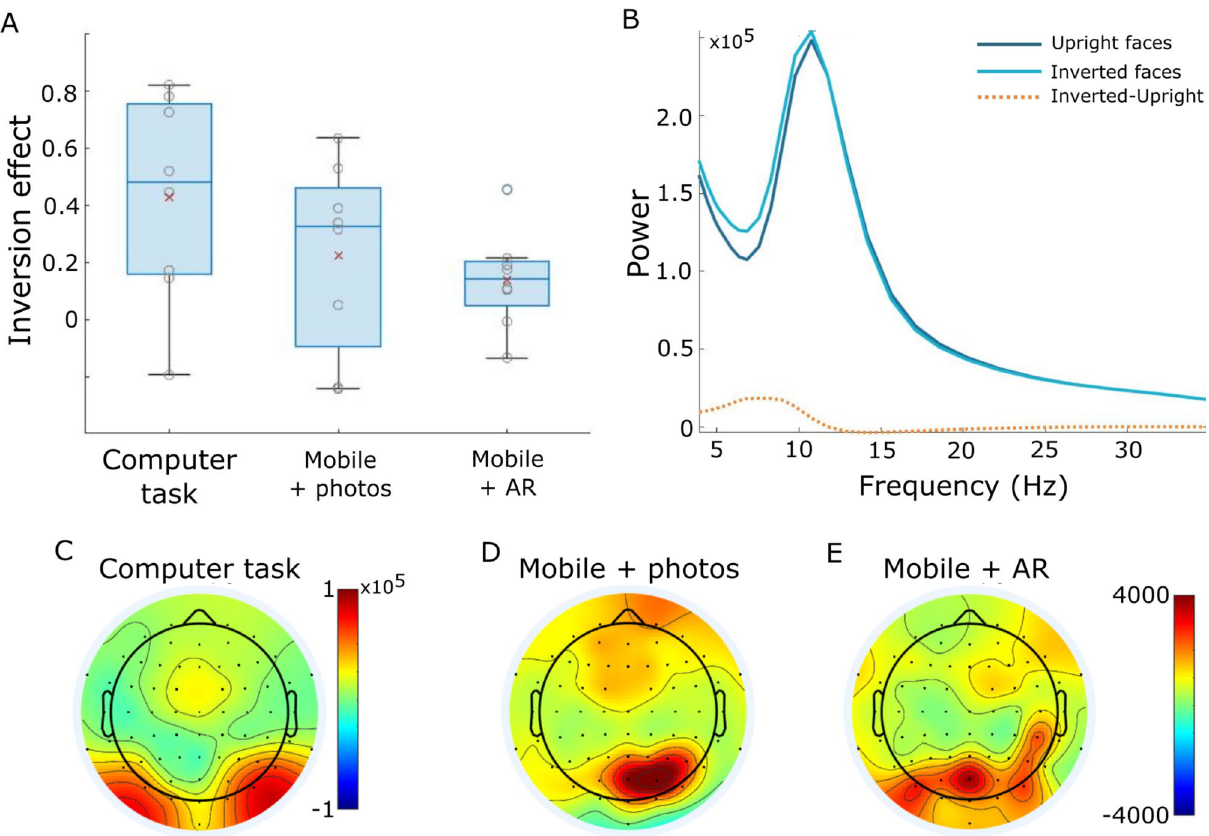
Figure 3. Epoch-based results. ( A ) Face inversion effect sizes for each experimental task based on the posterior electrodes. Red x indicates group mean inversion effect with individual subjects shown by grey circles. ( B ) Spectrogram showing group mean power between 4 and 35 Hz for upright and inverted conditions, and the difference between them. ( C – E ) Topographies showing mean power difference for inverted-upright faces between 5 and 15 Hz for the computer task ( C ), mEEG + photos ( D ) and mEEG + AR ( E